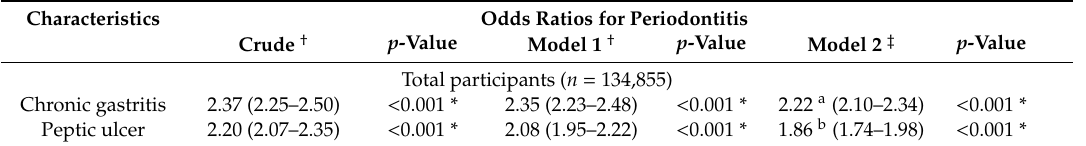
Table 2. Crude and adjusted odds ratios (95% confidence interval) of chronic gastritis and peptic ulcer for periodontitis.